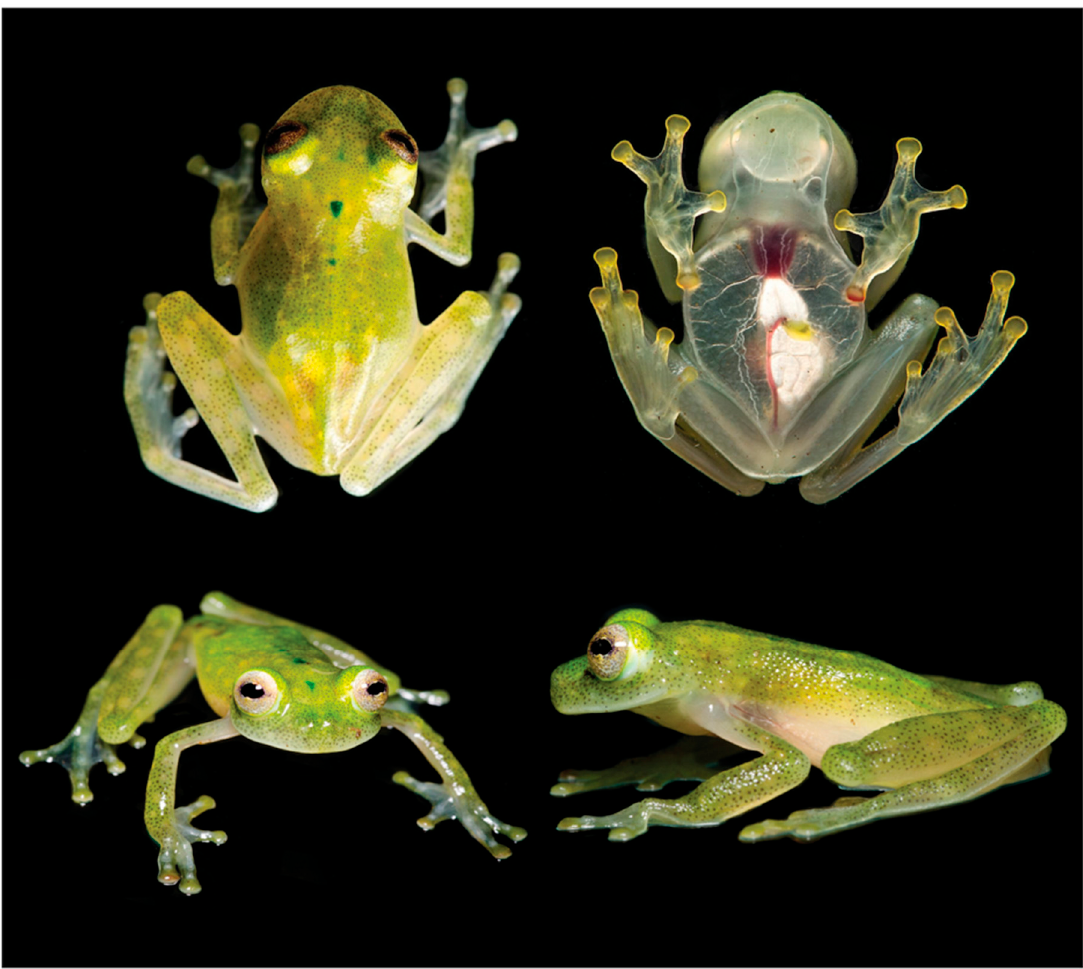
Figure 124. Hyalinobatrachium yaku in life. ( Top row ): adult male, MZUTI 5001, holotype, in dorsal and ventral view. ( Bottom row ): adult male, paratype, QCAZ 55628. Obtained from Guayasamin et al. [241]. Color in life (Figure 124): In adults, dorsum apple green to yellowish green with small